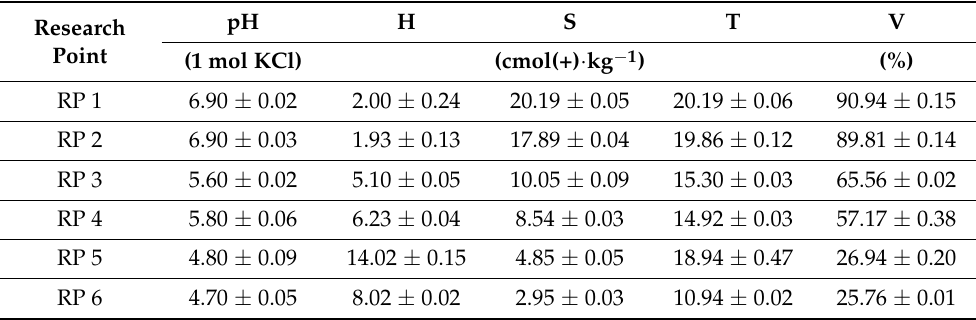
Table 1. Characteristics of research points on the outer heap of the Piaseczno mine. Soil Texture Tree stand beech dominant stand ( Fagus sylvatica L.) clay bearded birch stand ( betula pendula roth) European larch stand (larix decidua mill) weak clayey sands red oak stand ( Quercus rubra L.) predominantly hornbeam stand (Carpinus betulus) sands loose acacia robinia stand (tree stand from the upper part RP 6 of the slope) ( Robinia pseudacacia L.) Table 2. Characteristics of selected physicochemical properties. Average values. Characteristics of the soil prior to setting up the